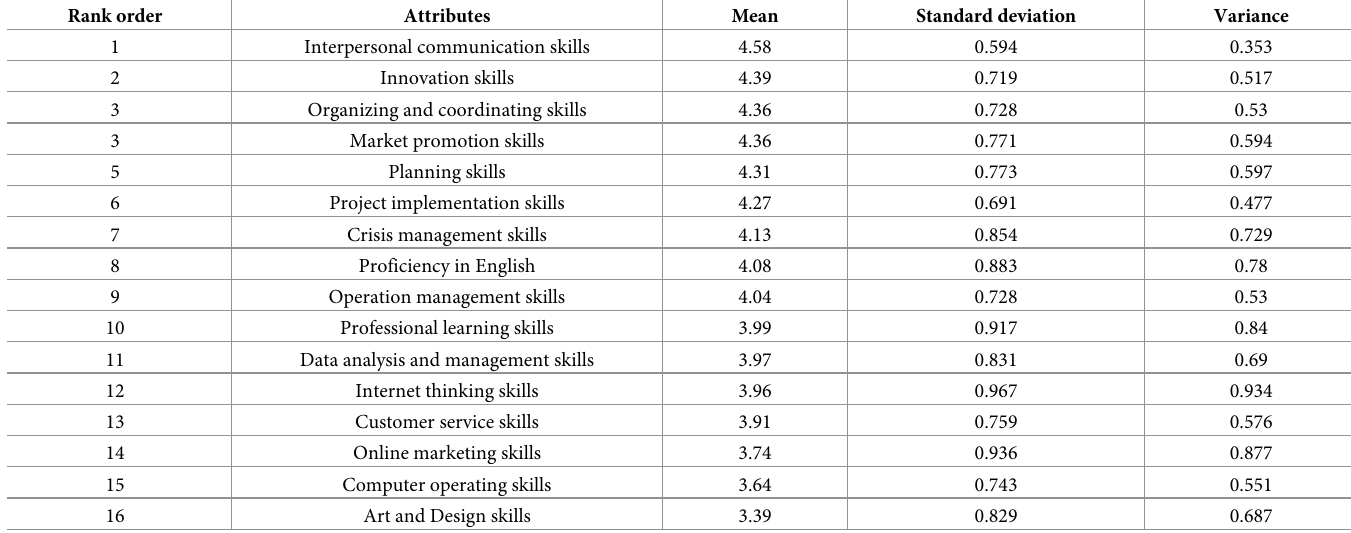
Table 2. Levels of importance for MICE employability